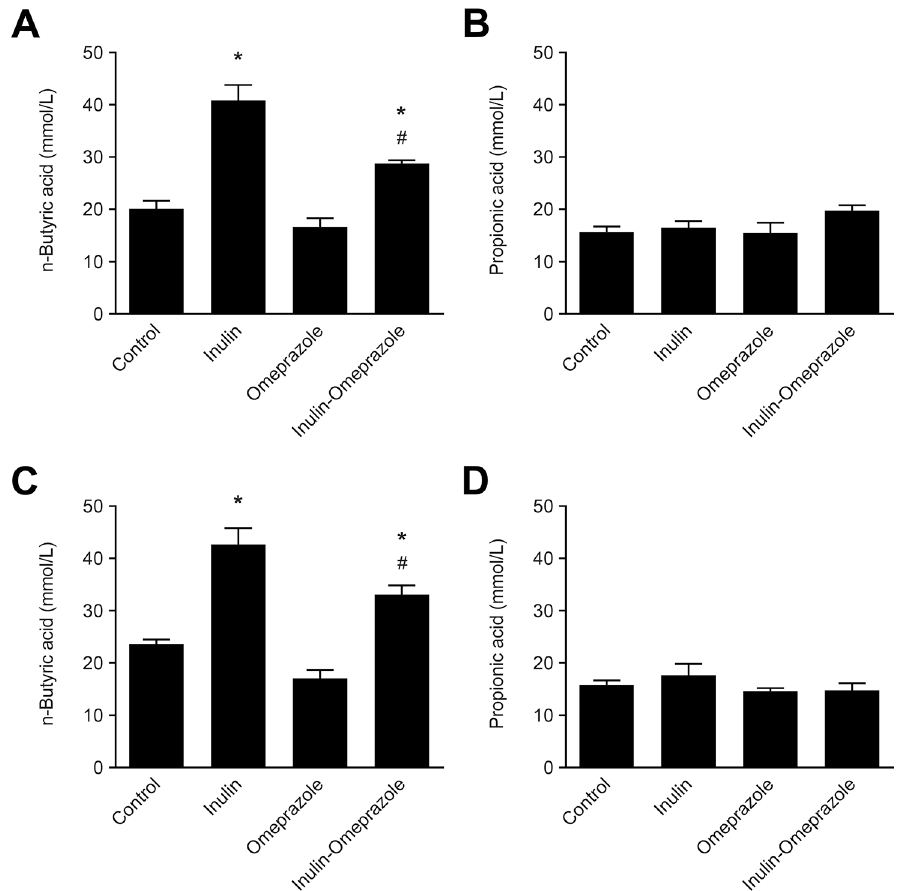
Fig 5. Effects of the combinatory application of omeprazole and inulin-enriched diets on short-chain fatty acid production. Depicted are n-butyric acid (A + C) and propionic acid concentrations (B + D) in cecum (top panels) and colon (bottom panels) in mmol/L. Significant differences compared to the control group are indicated by * with P < 0.05, significant differences between the omeprazole-treated groups are annotated by # with P < 0.05. Bars represent means ± SEM, with n = 10 mice per group.